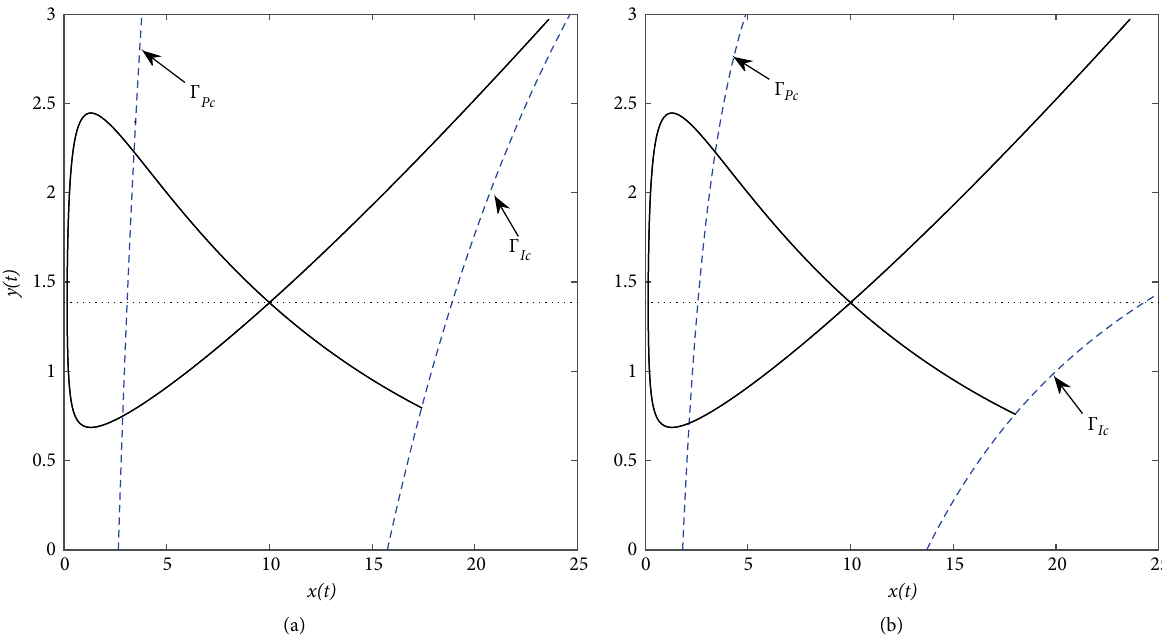
Figure 7: Effect of weighted parameters on Case are fixed as: